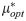
Self-replicator model accounts for bacterial growth laws.A: Predicted quasi-linear relation between the maximal growth rate μopt* and the corresponding optimal resource allocation αopt*, for different values of eM (different colors). The colored dots indicate αopt* and μopt* for kR = 2.23 h-1 and different eM, and the dashed black line the relation for all intermediate values of eM. The dashed colored lines indicate the relation between αopt* and μopt* obtained when, for a given value of eM, the value of kR is decreased (lower kR leads to lower μopt*). The solid grey curves correspond to (μ*, α)-profiles like those shown in Fig 2B. B: Measured relation between the total RNA/protein mass ratio and the growth rate, in different growth media with different doses of a translation inhibitor (data from [12]). For each medium, indicated by a color, five different concentrations of inhibitor were used (higher dose leads to lower growth rate). Growth-medium compositions are given in the original publication and error bars represent standard deviations. The dashed black and colored lines are the same as in panel A, indicating the good quantitative correspondence between model predictions and experimental data for the chosen parameter values, obtained by fitting the model to the data points (see Methods for details).